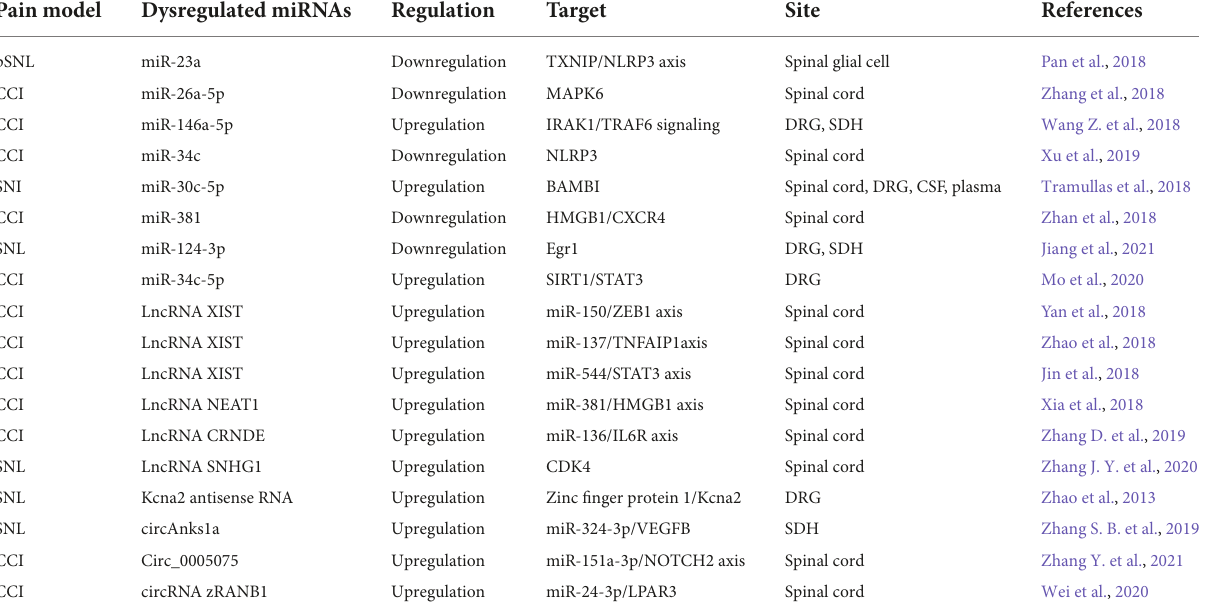
TABLE 1 Non-coding RNAs in different pain models regulate pain-related